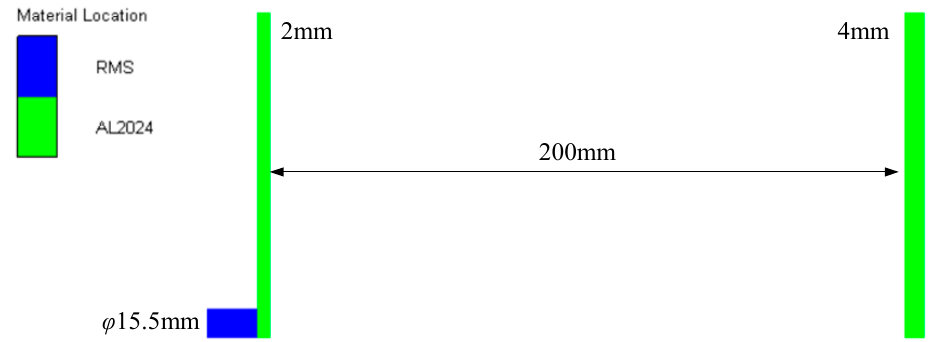
Figure 4. Scheme of simulation model.